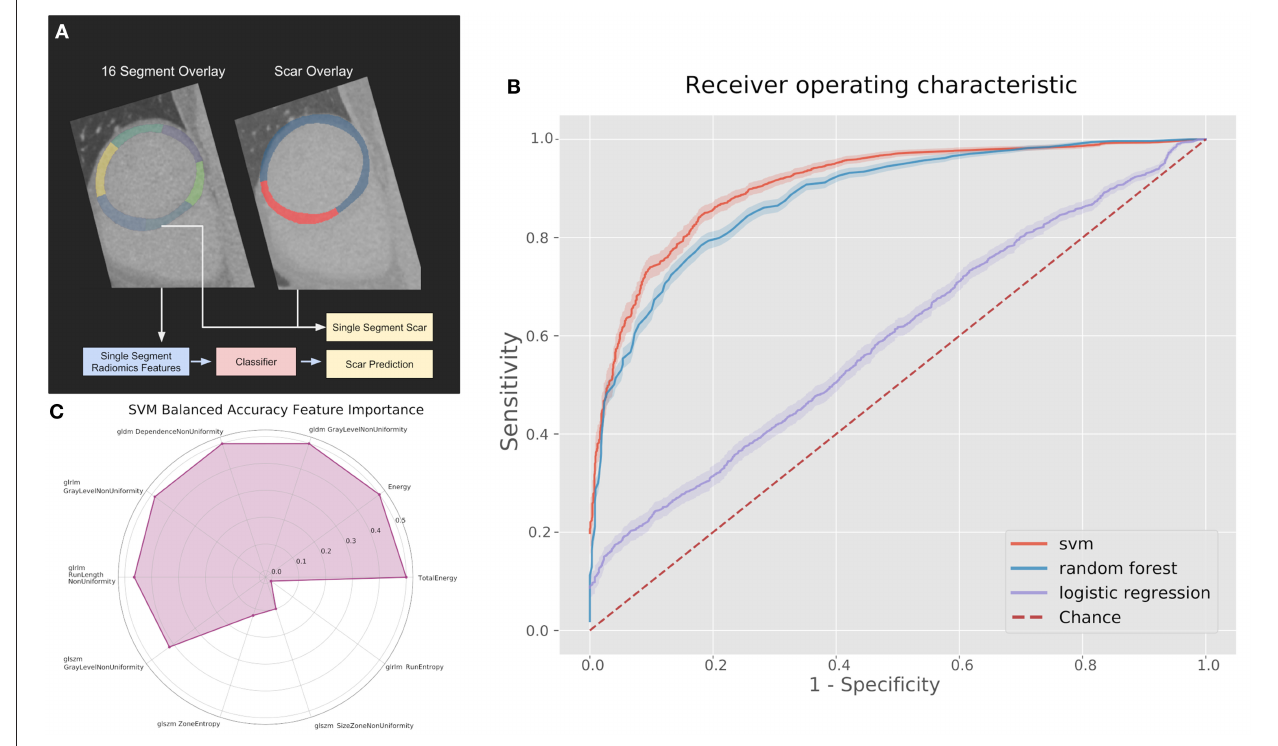
FIGURE 2 | (A) Pipeline and results of classification methods using the top 10 radiomic features per myocardial segment. (B) Receiver operating characteristics (ROC) curves for classifiers on the 100 kV images in the segmental analysis. (C) Permutation feature importance across the 10 features used in the support vector machine (SVM) for the 100 kV segmental classification. GLDM, Gray level dependence matrix; GLRLM, gray level run length matrix; GLSZM, gray level size zone